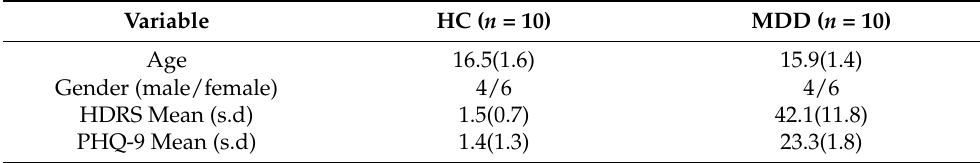
Table 1. Characteristics of MDD and HC adolescents.